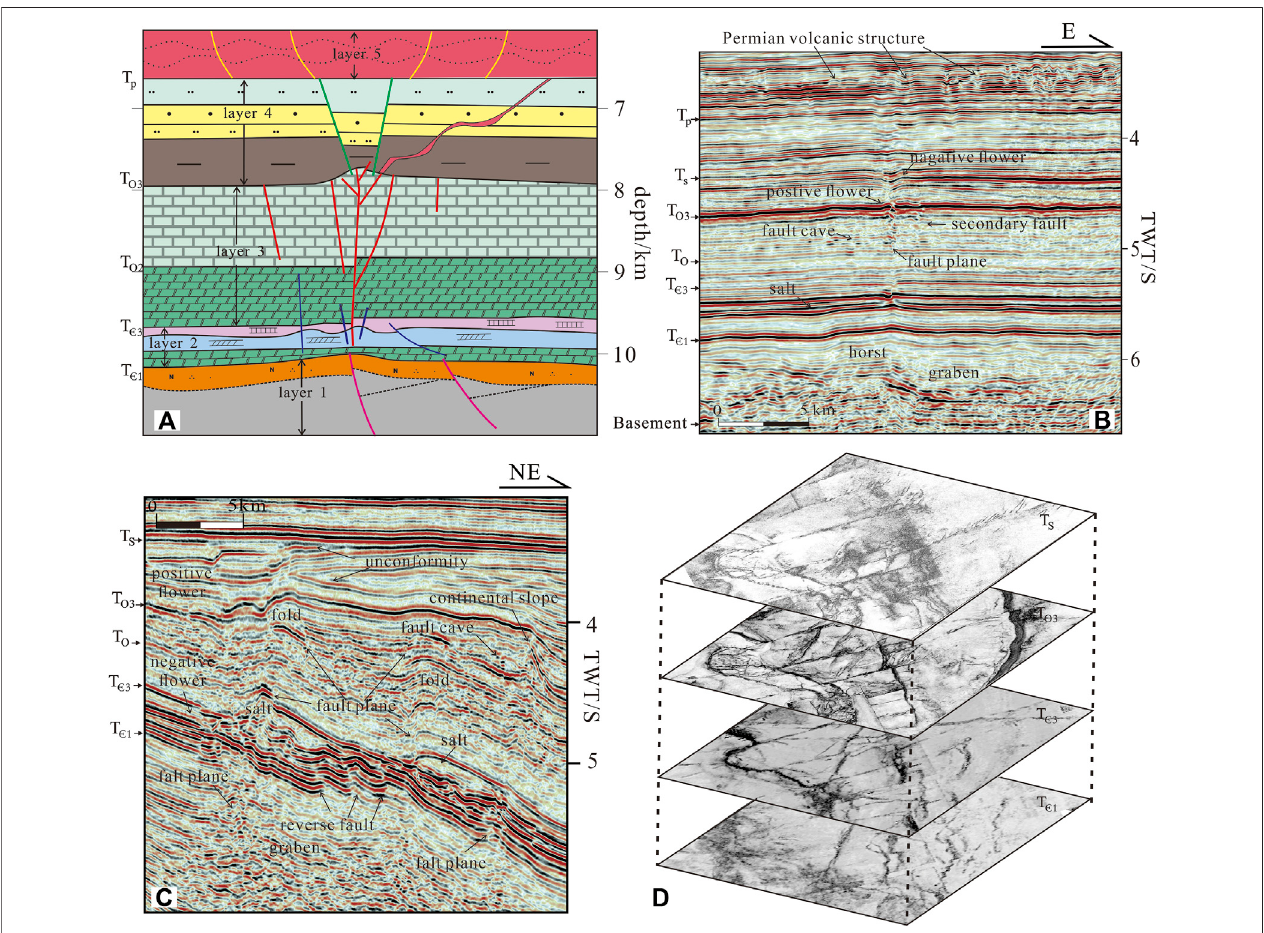
FIGURE 4 | Models of the strike-slip fault and typical seismic pro fi les and coherence cube slices of the main re fl ecting surface: (A) fi ve-layer strike-slip fault model, (B) typical seismic pro fi les of the Manxi low uplift, (C) typical seismic pro fi les of the Tazhong uplift, and (D) coherence cube slice of the main re fl ecting surface of the Tazhong